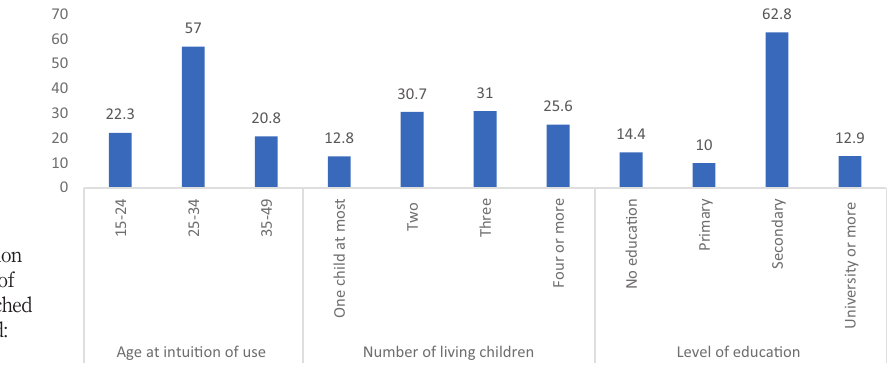
Figure 3. Per cent